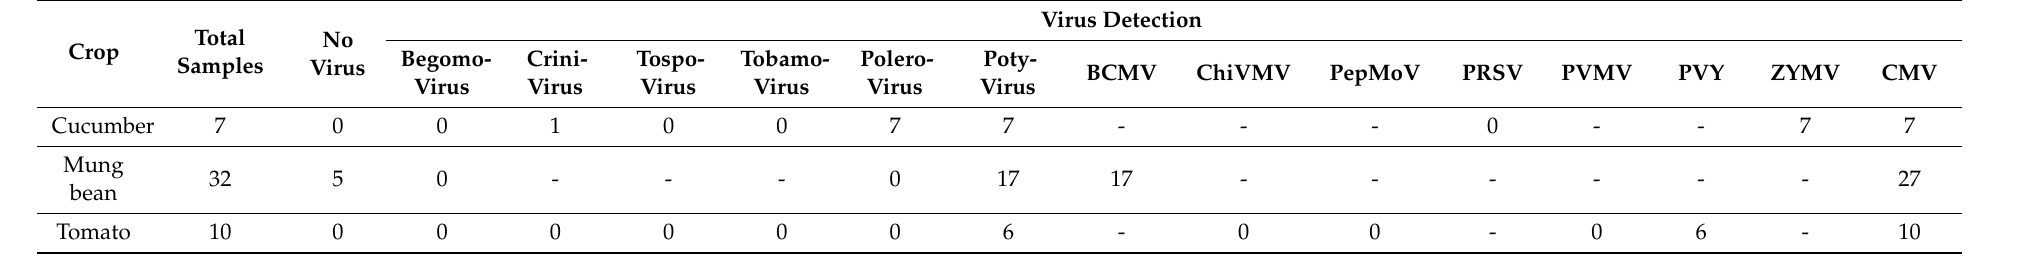
Table 2. Summary of virus detection in vegetable samples collected in